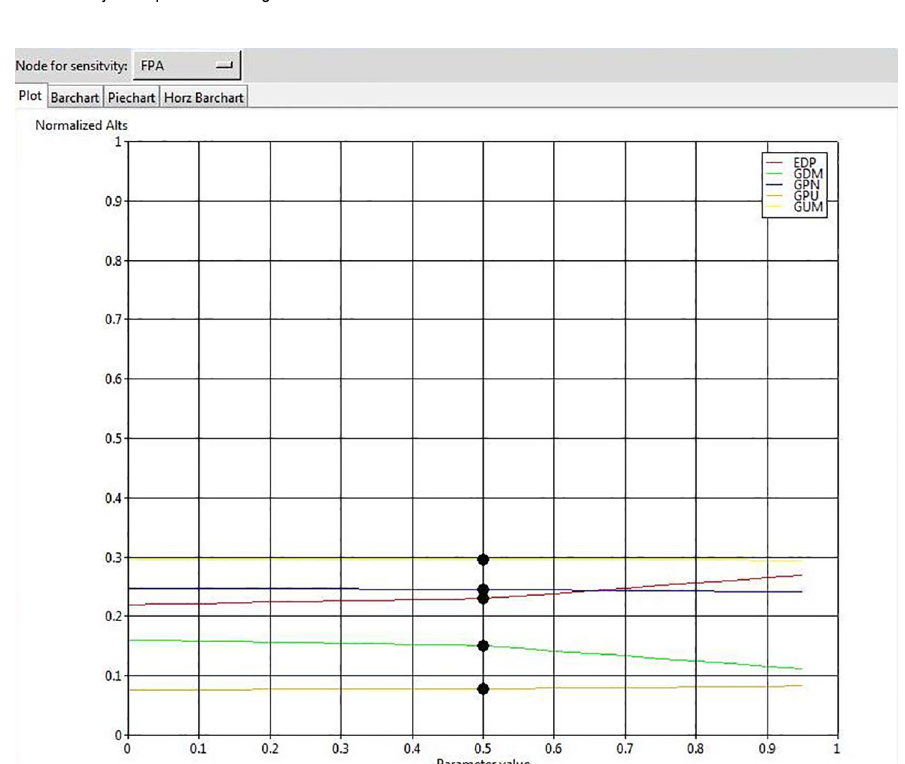
Fig 5. The results of sensitivity analysis for the node “ Future Positioning ”